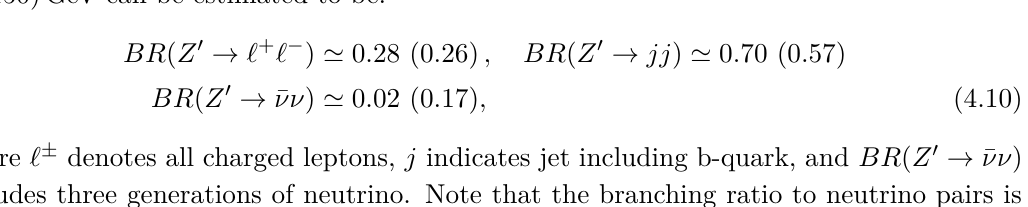
XENON1T [10]. From both plots, it is seen that the results of DM-nucleon scattering cross section in the model are still under the constraints of the direct